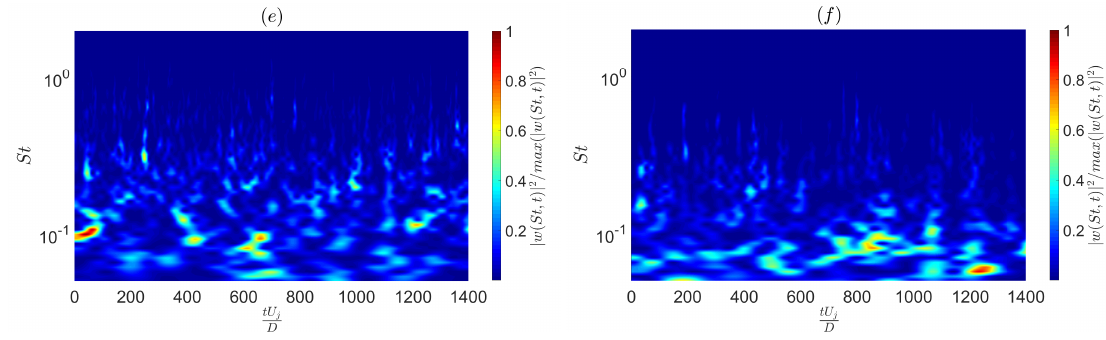
Figure 9. Wavelet scalograms—on the left, H/D = 0.75, on the right, H/D = 2—for: ( a ) x/D = 5 and M j = 0.5; ( b ) x/D = 5 and M j = 0.5; ( c ) x/D = 5 and M j =0.9; ( d ) x/D = 5 and M j =0.9; ( e ) x/D = 25 and M j = 0.5; ( f ) x/D = 25 and M j =